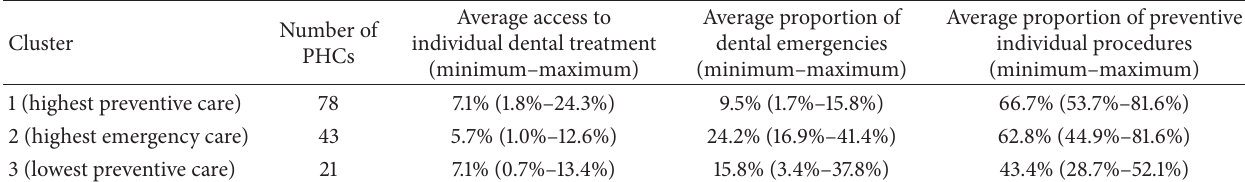
Table 2: Description of primary dental care performance in each cluster, Belo Horizonte, 2010.